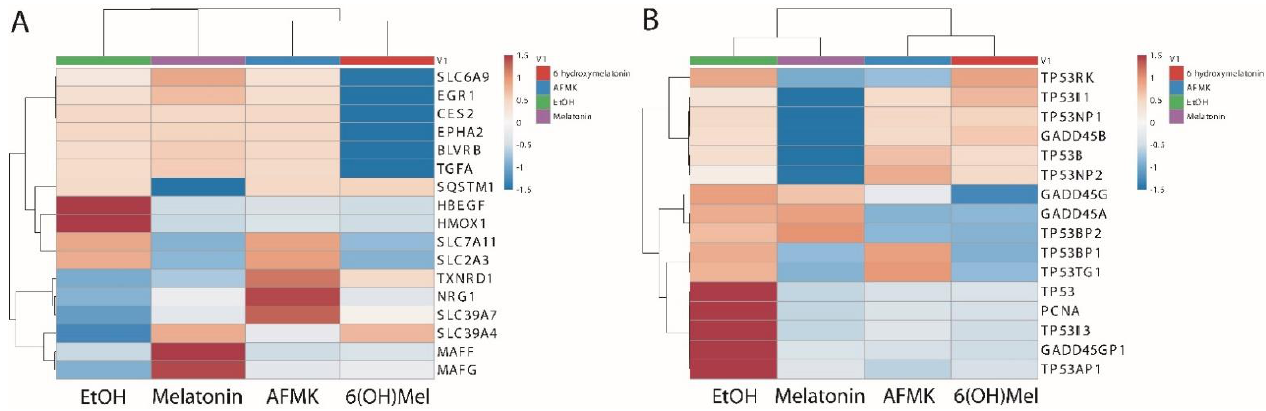
Figure 3. Heatmaps for NRF2 ( A ) and TP53 ( B ) signaling pathways after treatment of human epidermal keratinocytes with melatonin and its derivatives.